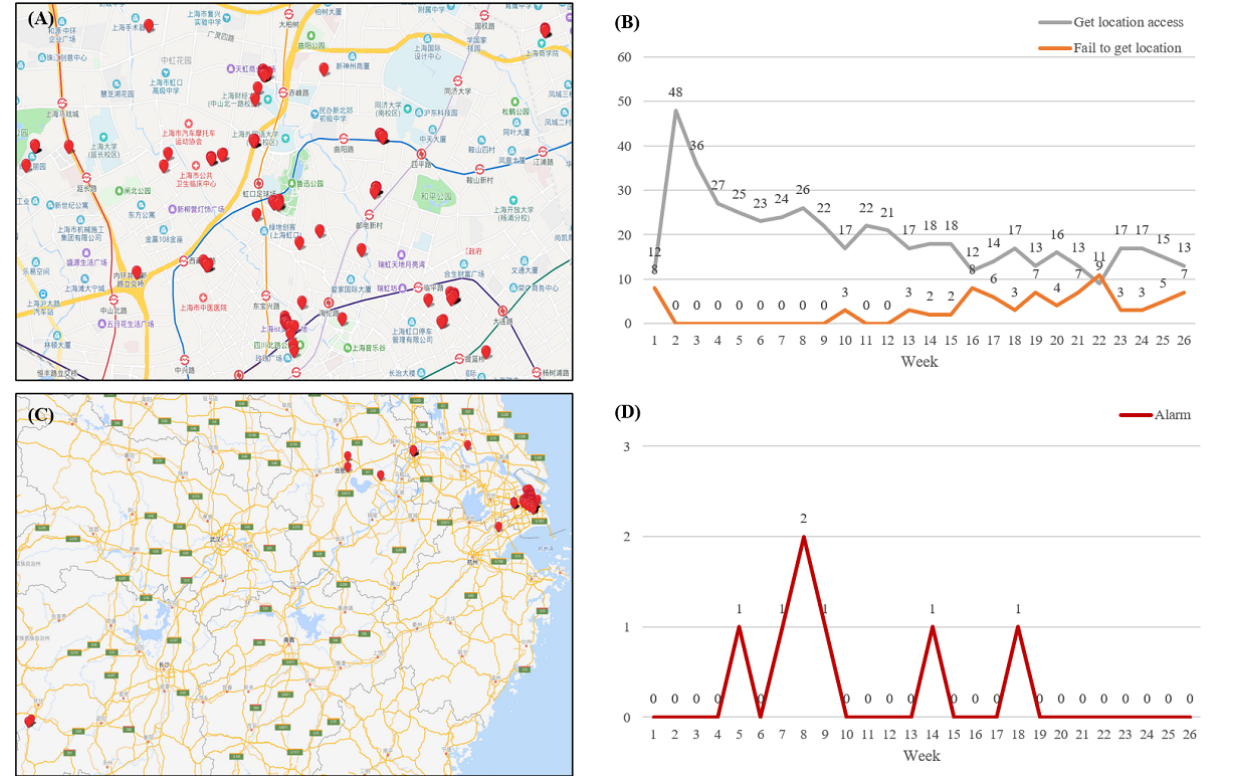
Figure 2. Location-tracking feature for social workers to monitor participants in intervention group: (A) close shot of Shanghai: drug users moving around within the supervision area; (B) number of locations accessed and not accessed (failed) from CAREs app per week; (C) remote view of Shanghai: some drug users had left the supervision area without reporting to the matched social workers, and the system automatically initiated alarm; and (D) number of alarms per